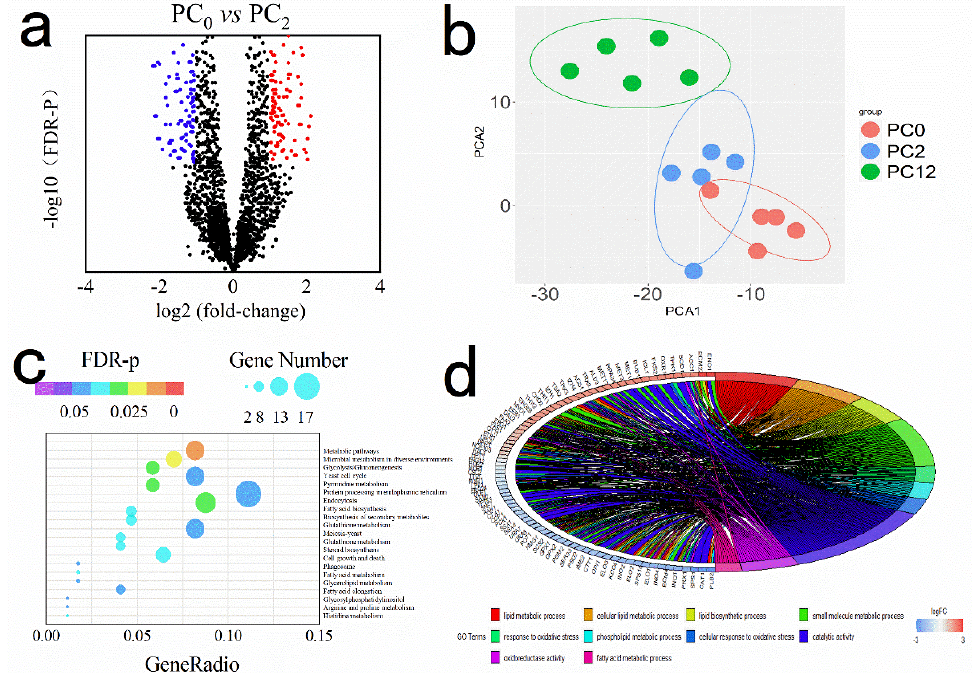
Figure 4. ( a ) Volcano plots showing the distribution of DEGs between U+nano-Se@PC 0 and U+nano- Se@PC 2 , arranged by fold-change (x axis) and FDR-p values (y axis). DEGs are colored blue (down- regulation) and red (up-regulation). ( b ) PCA of normalized value of all genes in PC 0 , PC 2 and PC 12 groups (5 replicates in each group). ( c ) KEGG pathway enrichment analysis of DEGs between U+nano-Se@PC 0 and U+nano-Se@PC 2 . ( d ) GO classification of DEGs between PC 0 and PC 2